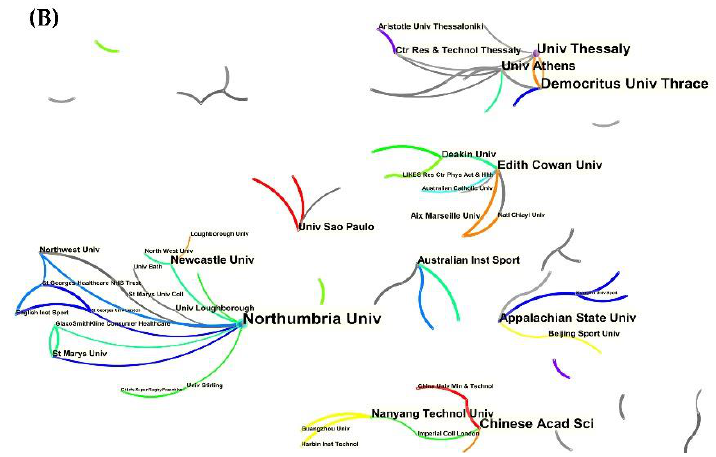
Figure 3. The collaboration network of countries and institutions. ( A ) The collaboration network of countries; ( B ) the collaboration network of institutions.